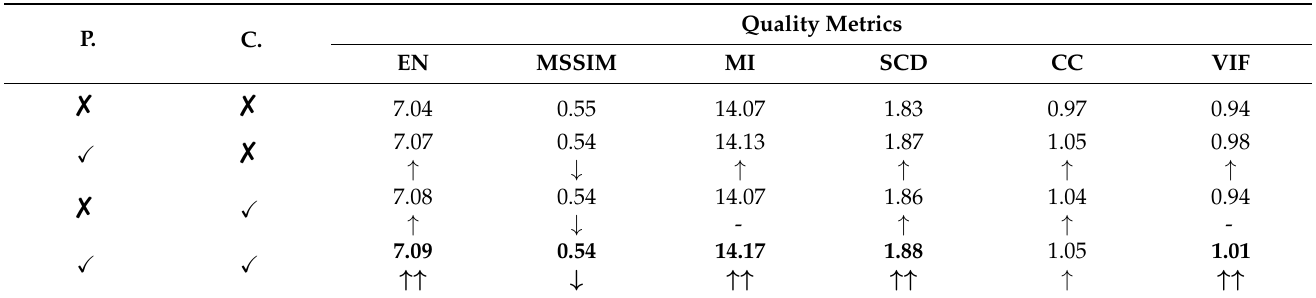
Table 3. Ablation study on the effectiveness of Pull–Push loss function and Semantic Constraint module (P. indicates Pull–Push loss function; C. indicates Semantic Constraint module). Bold represents for the best result in comparison. ↑ represents an improvement compared with the original algorithm, and ↓ is the opposite.